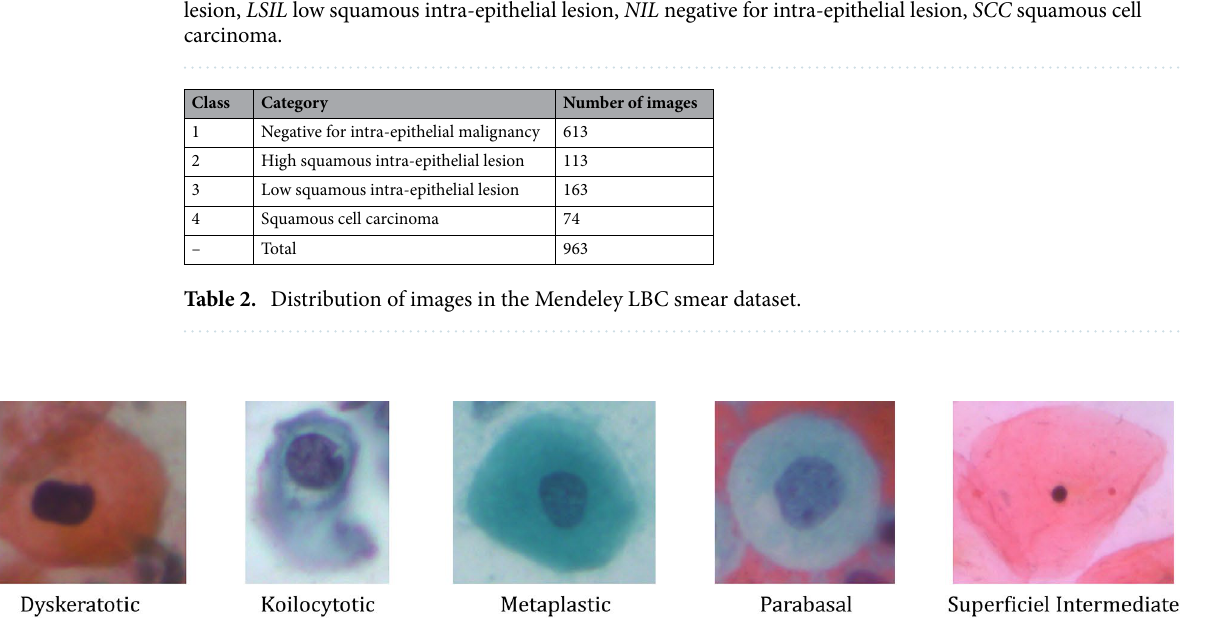
Figure 10. Examples of images from the SIPaKMeD Pap Smear dataset 9 .